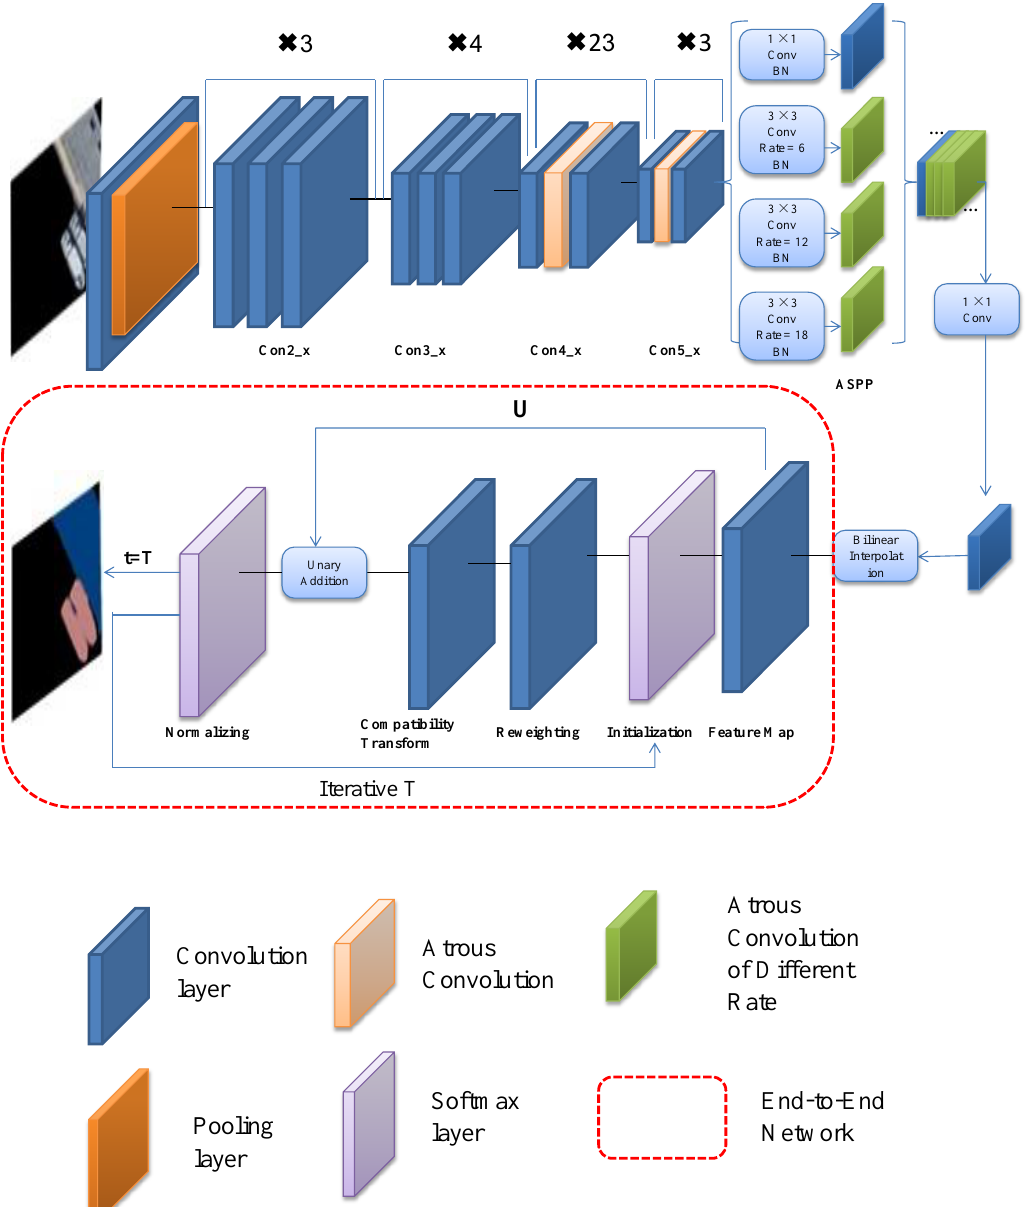
Figure 2. Deep semantic segmentation (DSS) convolution structure diagram.